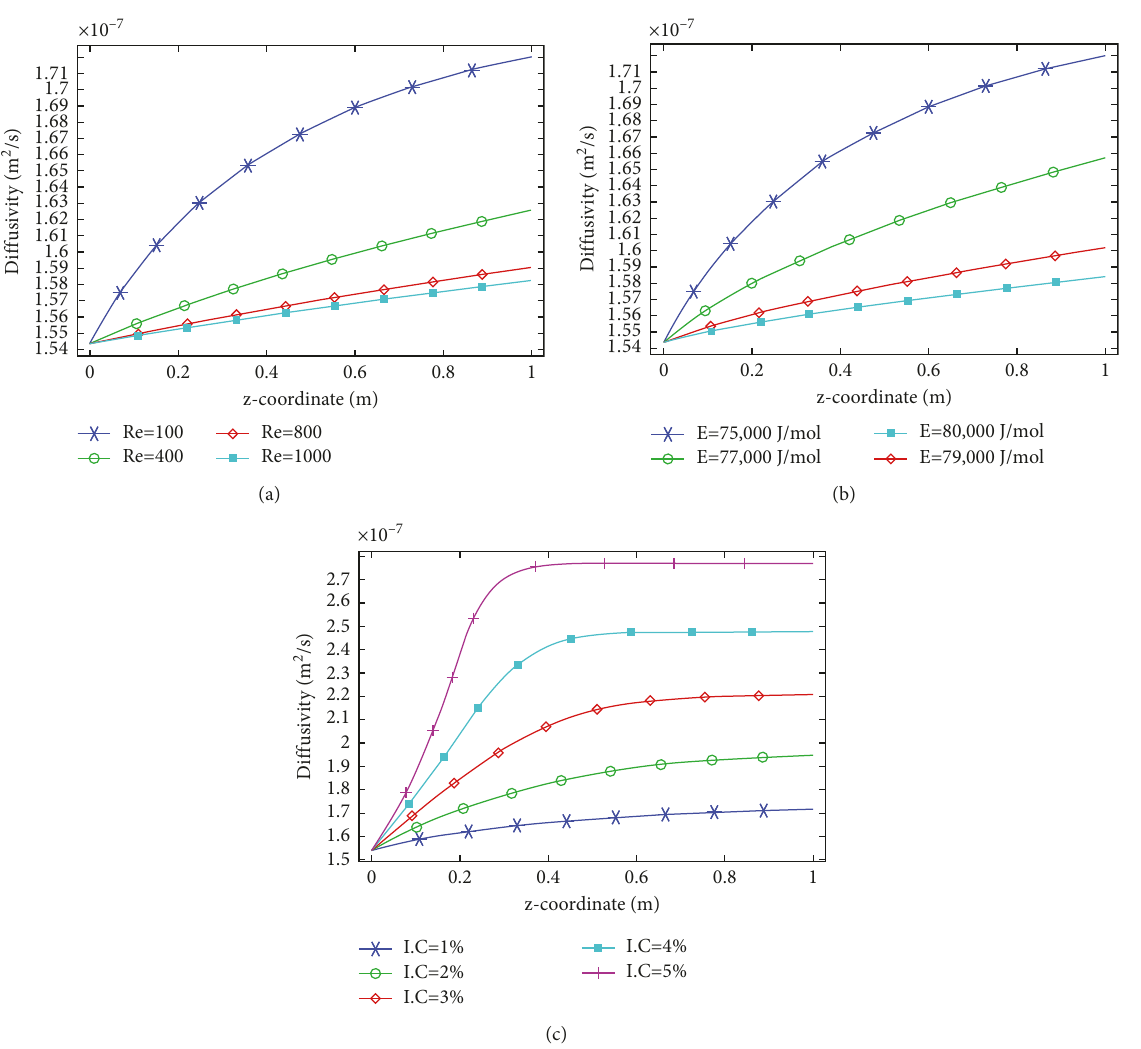
Figure 12: Diffusivity of calcium oxide in water: (a) I.C � 1%, E � 75,000J/mol; (b) I.C � 1%, Re � 100; (c) Re � 100, E �